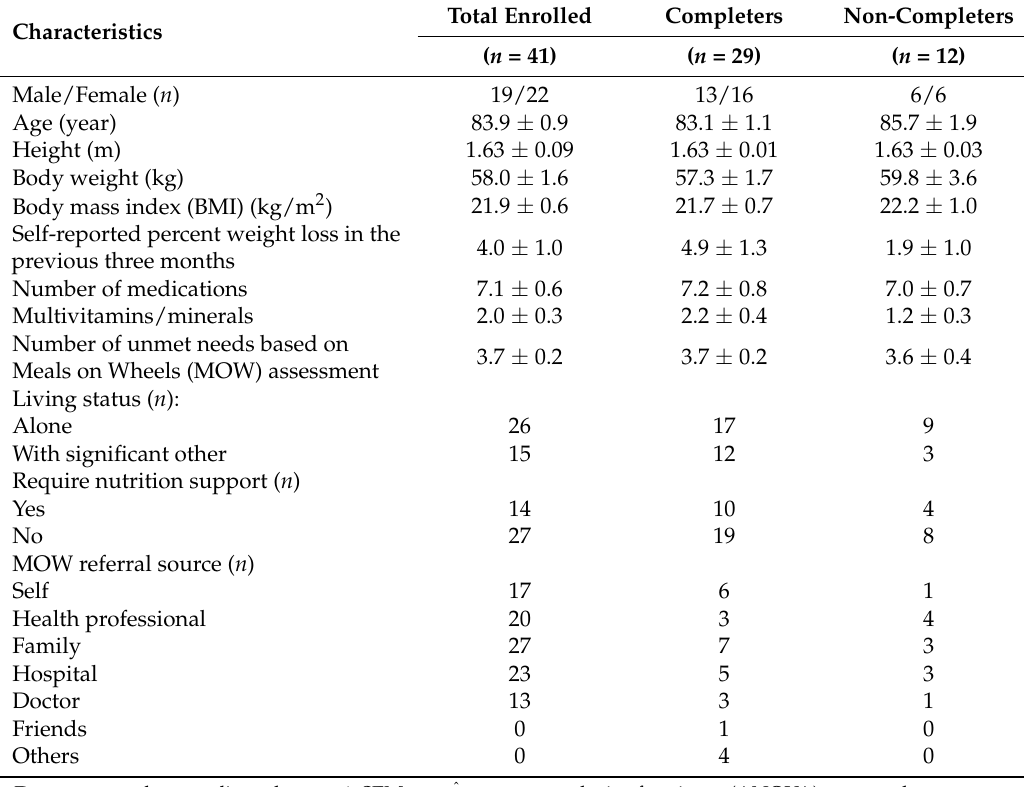
Table 1. Baseline characteristics of the total participants, completers and non-completers ˆ